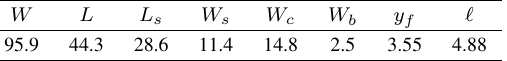
Fig. 19 in order to test the performance with active switches.